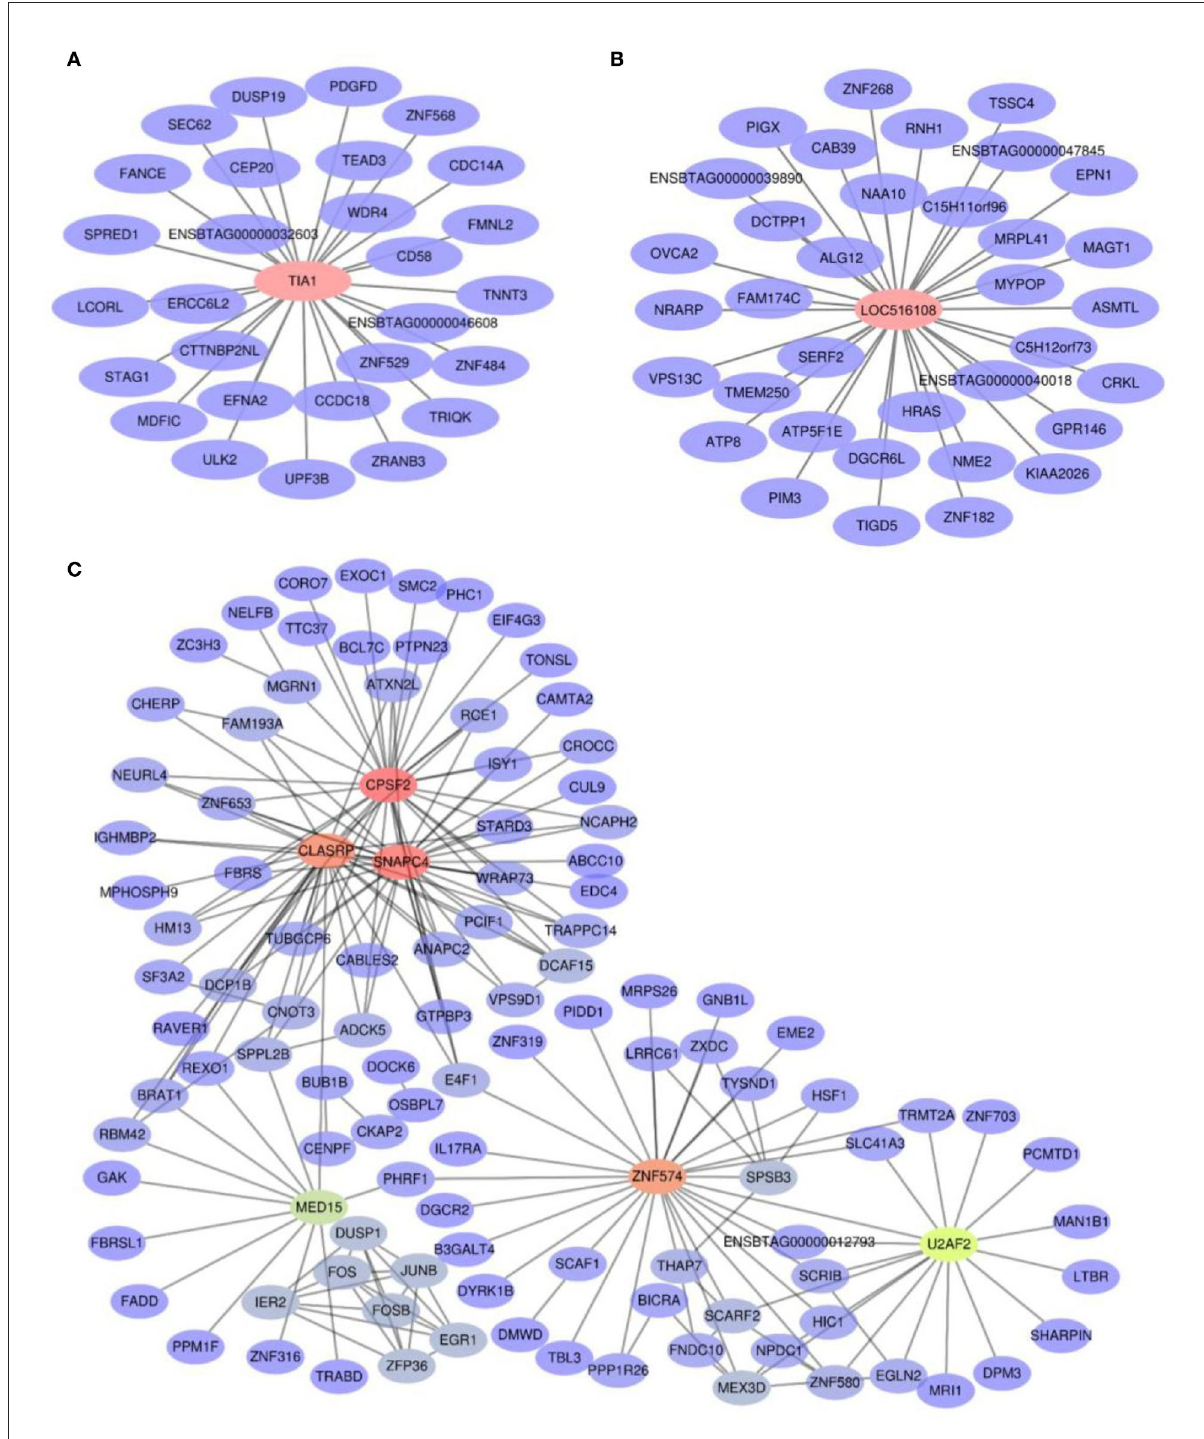
FIGURE5 Co-expression network diagram of the interaction between hub genes and their target genes. (A) Grey60 module. (B) Magenta module. (C) Pink